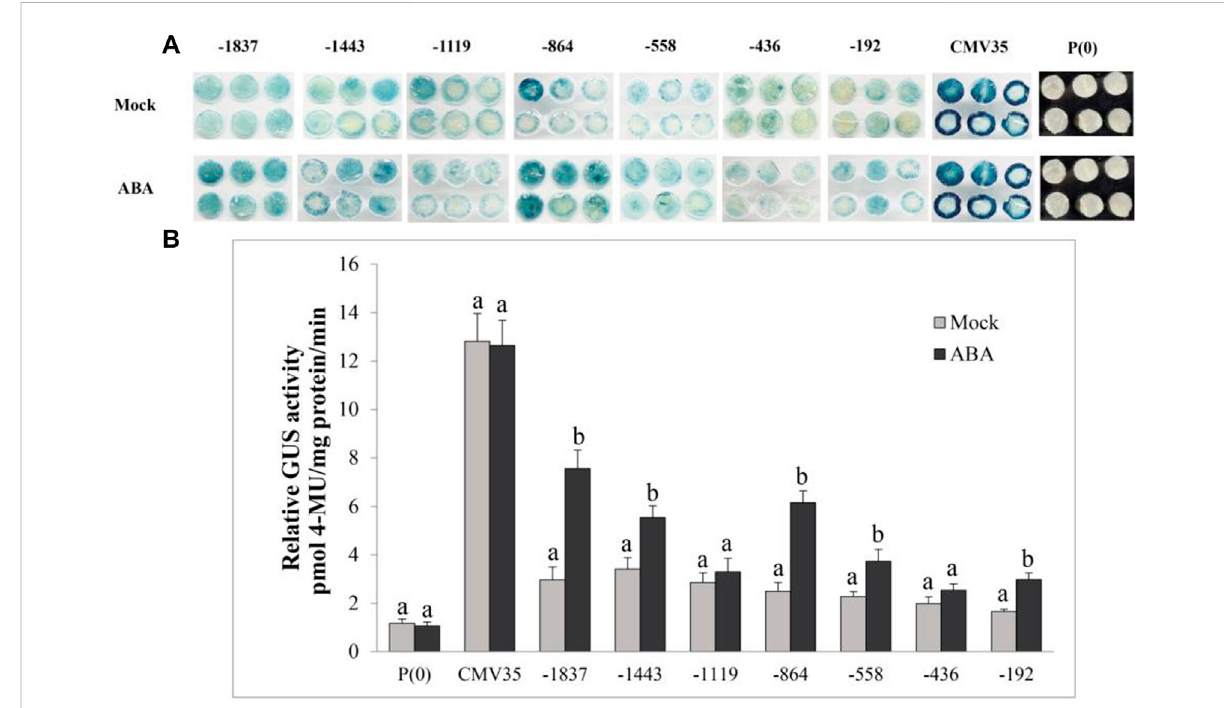
FIGURE 8 Histochemical staining and fl uorometric assay of VvPR1 in response to ABA. (A) Histochemical staining analysis; GUS activity in transiently transformed N. benthamiana leaves with serially deleted VvPR1 promoter fragments ( − 1,837, − 1,443, − 1,119, − 845, − 558, − 436, and − 192) bp against ABA. (B) Fluorometricassayof VvPR1 promoterfragments( − 1,837, − 1,443, − 1,119, − 845, − 558, − 436,and − 192)bpinresponsetoSAintobaccoleaves through transient expression. Different letterson thebars showed asigni fi cant difference between the SA-treated promoter fragments and